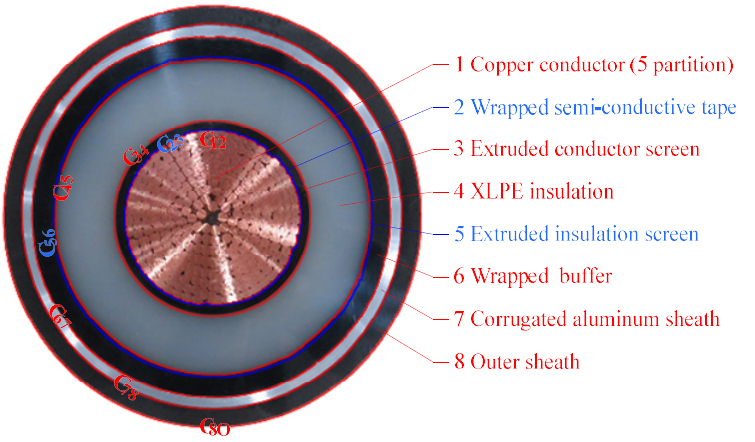
Figure 1. Cross-section of the structure of typical single-core cable.